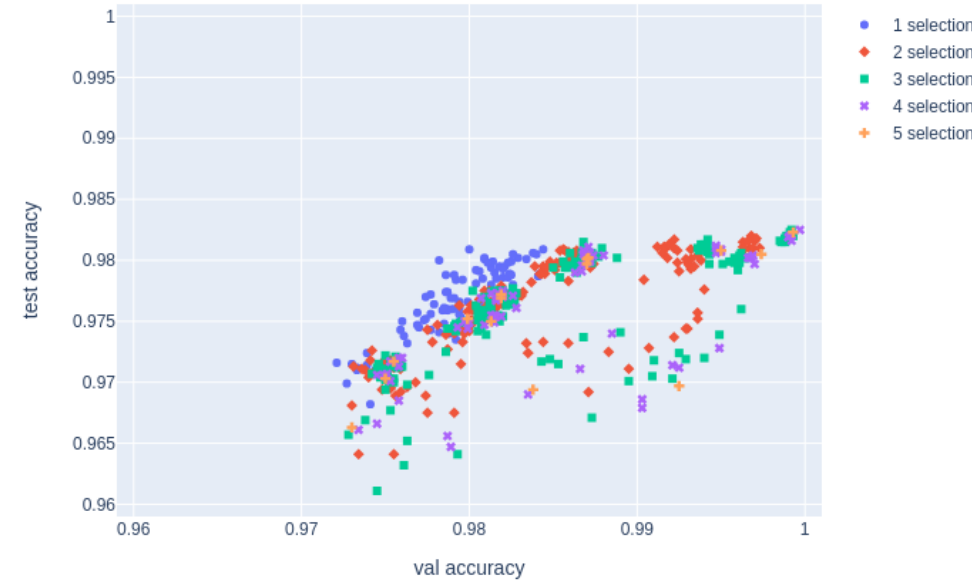
Figure 4. Val and test accuracies for models with val accuracy greater than or equal to that of the model with the lowest val accuracy before the application of uniform soups in Figure 3.